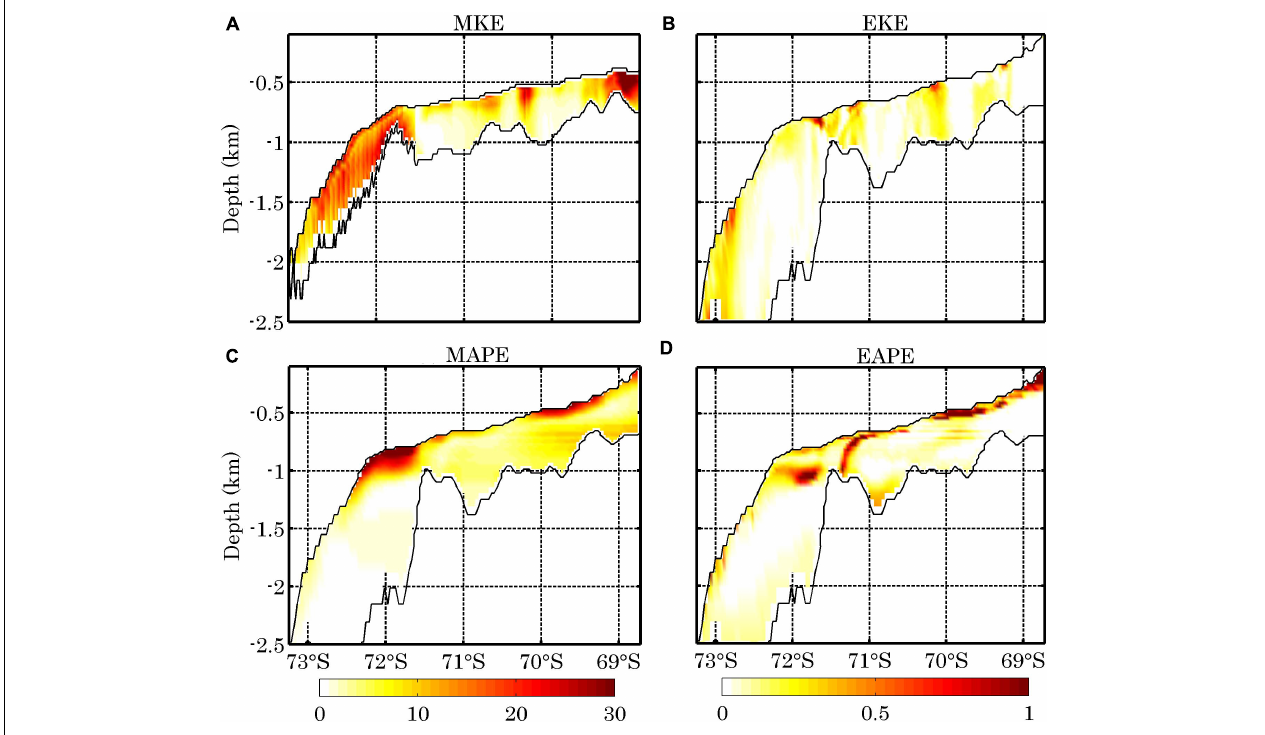
FIGURE 4 | The annual mean vertical distributions of MKE ( A , J m − 3 ), EKE ( B , J m − 3 ), MAPE ( C , J m − 3 ), and EAPE ( D , J m − 3 ) along the sections indicated in Figure 2 . Note that the location of the vertical cross section of MKE is different from those of MAPE, EAPE, and EKE.